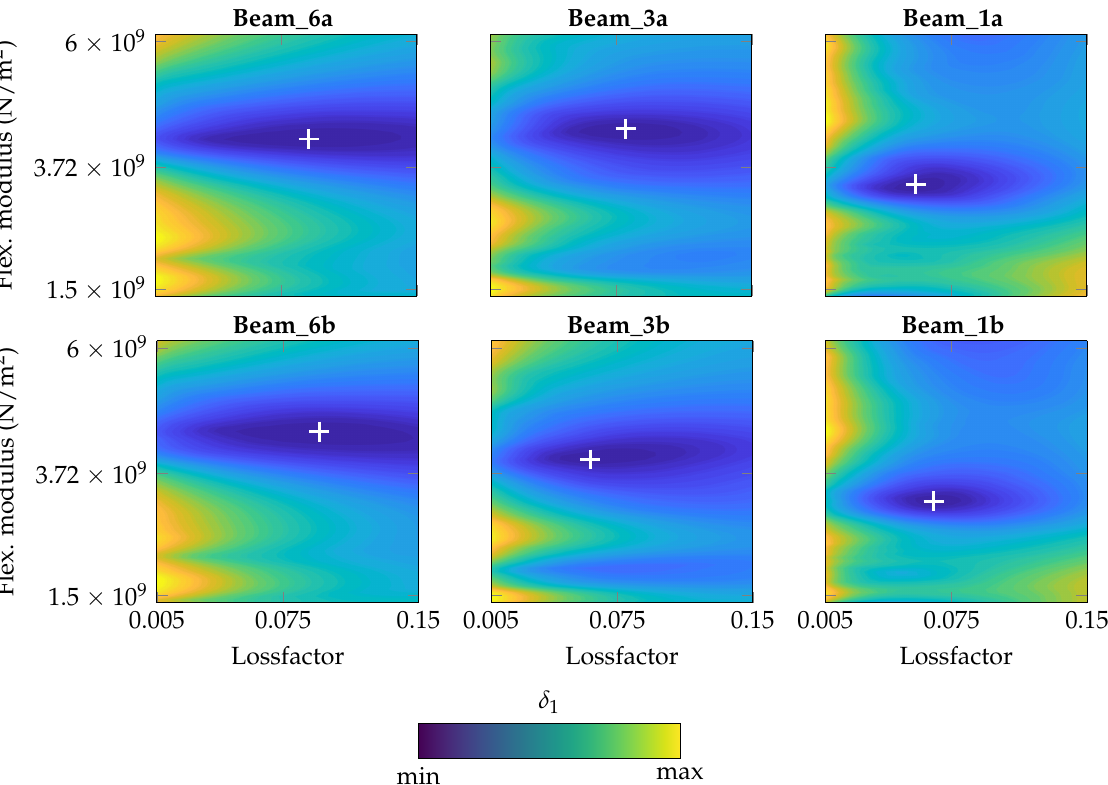
Figure 11. δ 1 contour plot for each specimen with identified optima under variation of E and η (frequency-independent, constant